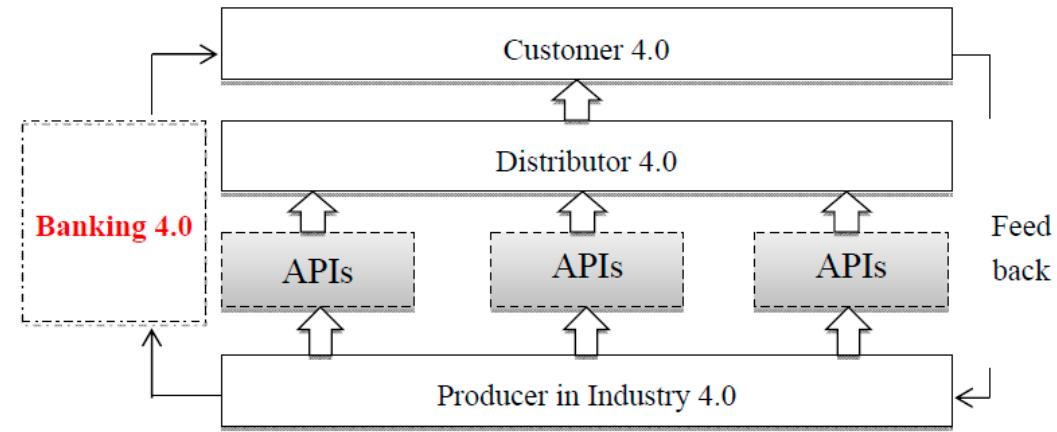
Figure 11. The role of application programming interfaces (APIs) in Industry 4.0. Source: Own contribution of the authors.